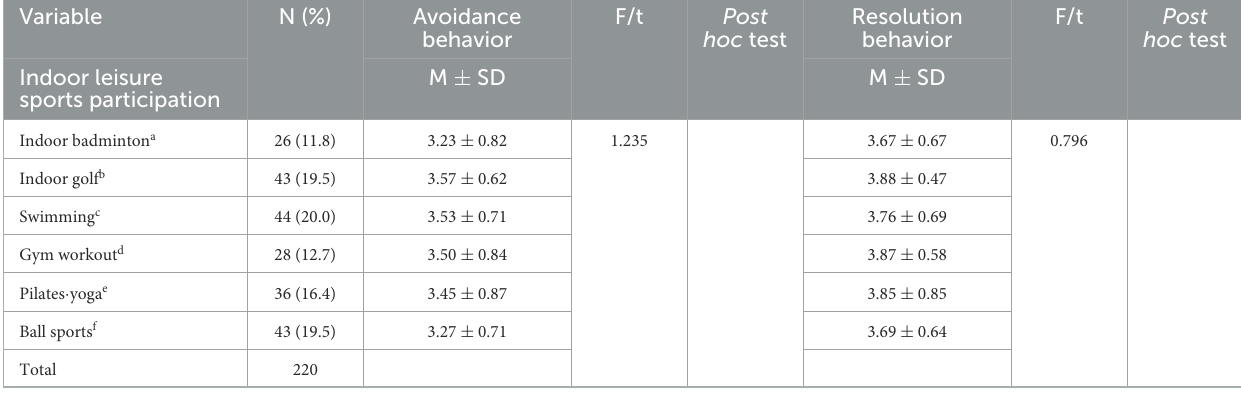
TABLE 5 Differences in coping strategies among indoor leisure sports ( N = 220).